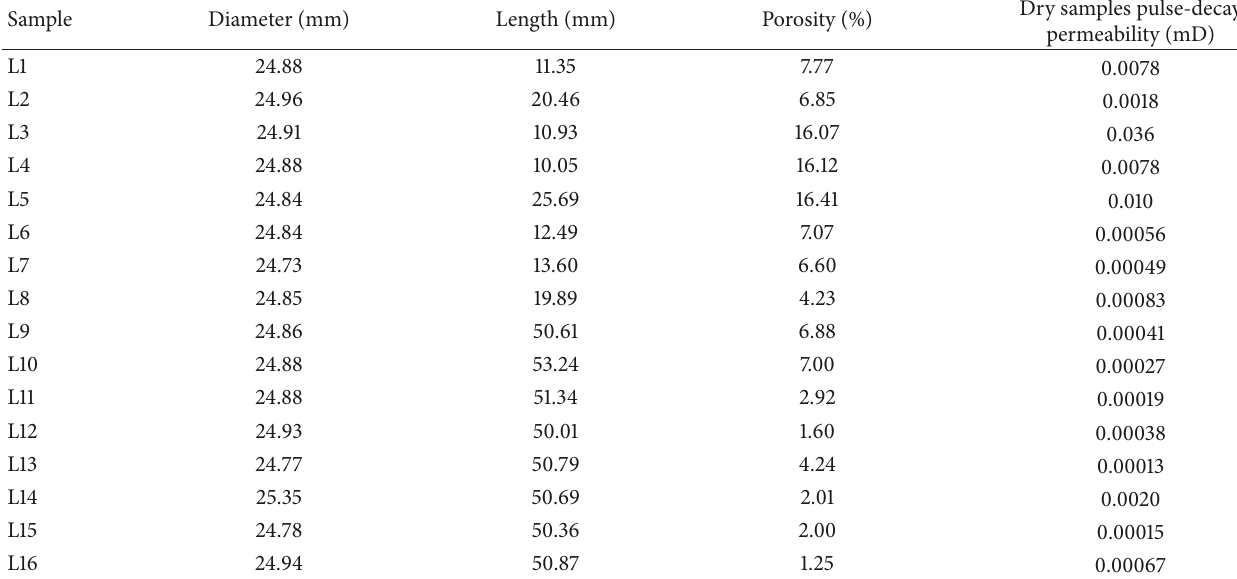
Table 1: Dimensions, porosity, and permeability of various samples.